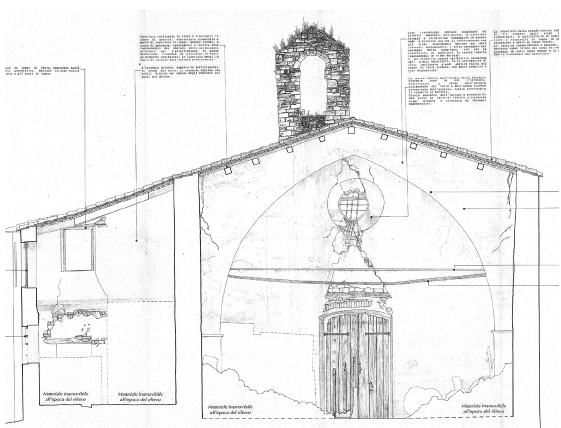
Figure 1: in old-style decay mapping, restorers did not use graphical areas and hatch to represent the state of conservation, but they preferred to draw the current situation with also the smallest